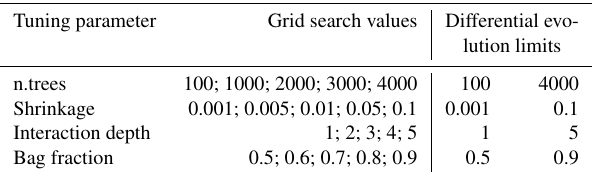
Table 1. Tuning parameter values to be tested by grid search, and optimization limits required by the differential evolution algorithm. Tuning parameter Grid search values Differential evo-